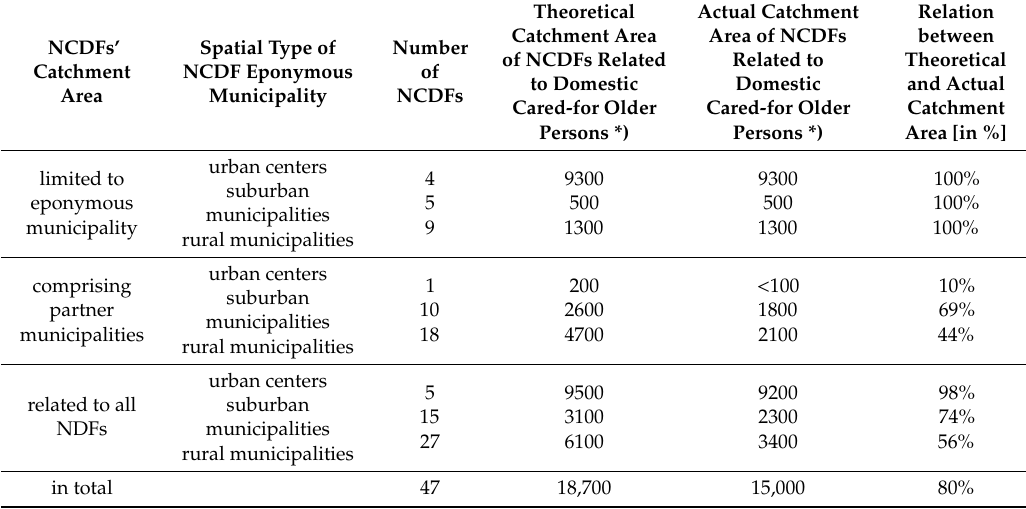
Table4. TheoreticalandactualcatchmentareasofNCDFs(eponymousandnursingcarediscussionclusters) related to the number of domestically cared-for older persons living in NCDF location municipalities.